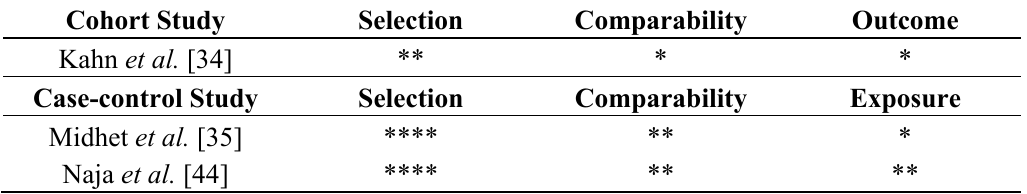
Table 4. Methodological quality of the cohort study and case-control